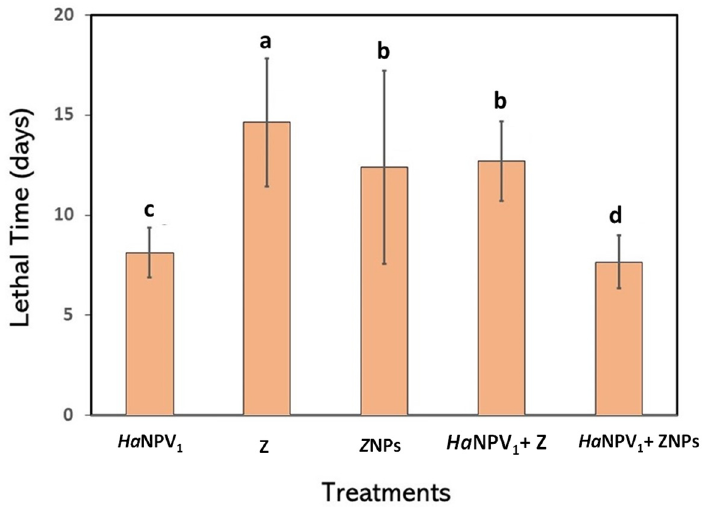
Figure 6. Lethal time of Spodoptera litura (Fabr.) infected by different formulation. The letter a–d indicate significant difference within treatments (Duncan’s Multiple Range Test, p < 0.05). Ha NPV 1 formulation in Z and ZNPs resulted in lethal times of 7.7 and 6.2 days, re-